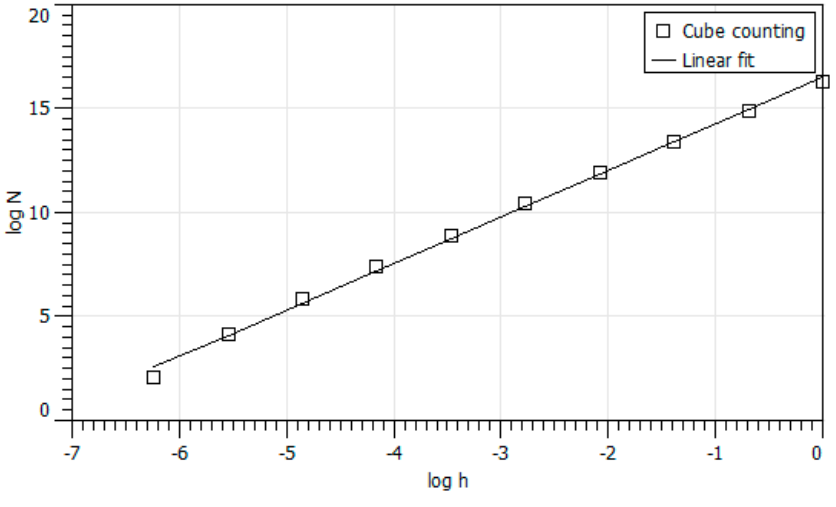
Figure 2. Grain surface fractal dimension D H = 2.263, α s = 0.263.